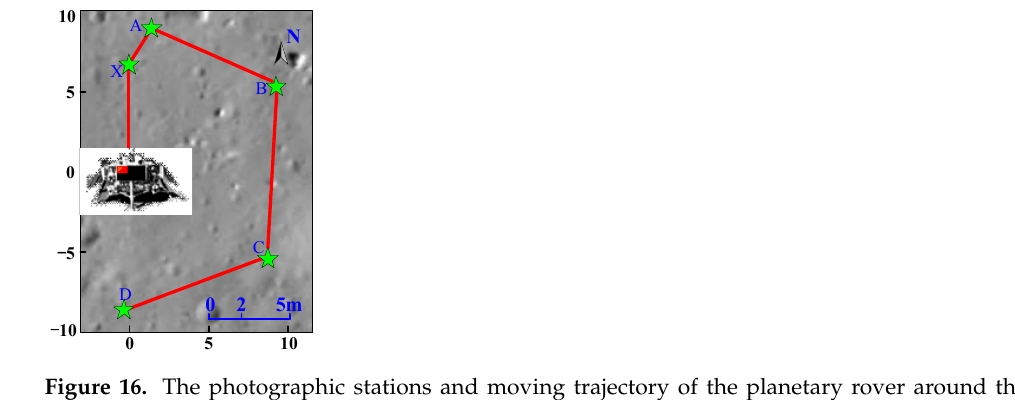
Figure 16. The photographic stations and moving trajectory of the planetary rover around the Chang’e-3 lander. The source of the background image was taken by the descent camera. The in-orbit calibration process of the navigation cameras can be divided into four steps: (1) extraction of the image point coordinates of the virtual control points and the matching connection points, (2) calculation of the initial EO elements, (3) self-calibration bundle adjustment with multiple constraints, and (4) accuracy assessment. Since no checkpoints with known coordinates were on the lunar surface, the accuracy of the camera parameters was evaluated based on the dimensions of the devices on the rover and the positioning results of the planetary rover.